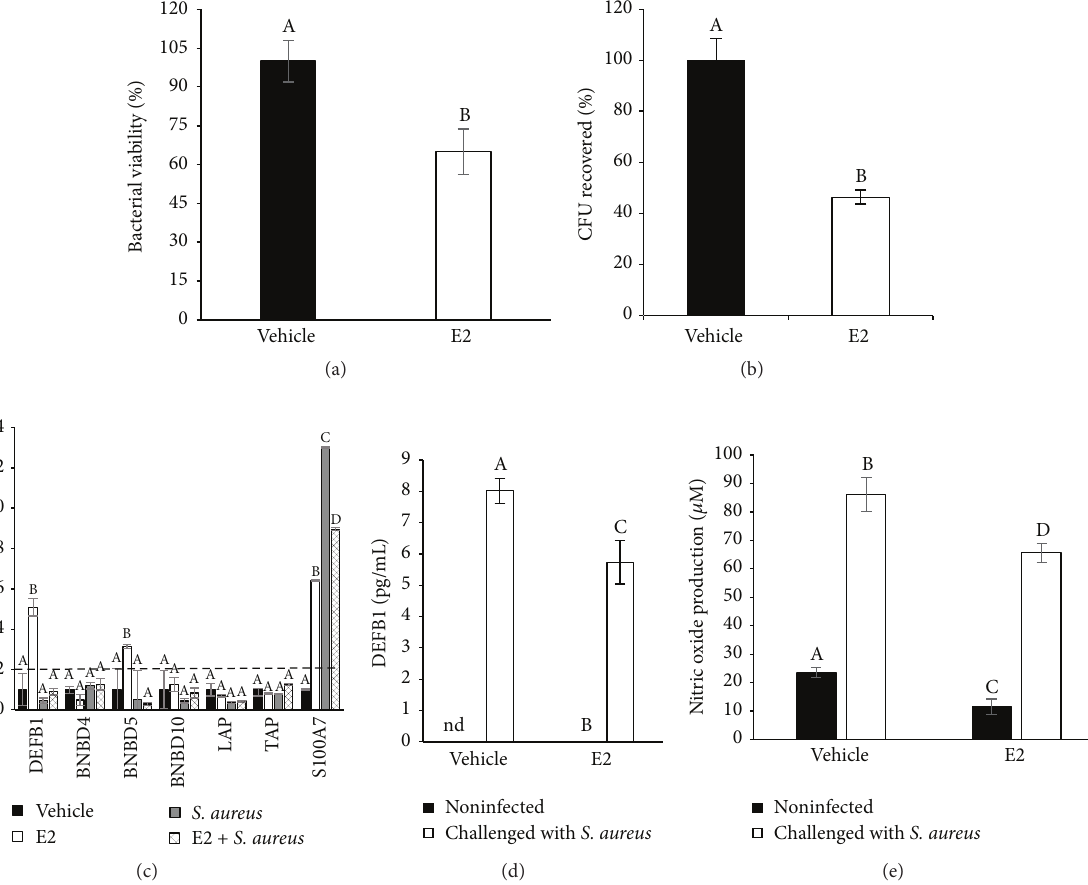
Figure 8: Expression and production of antimicrobial molecules in bMECs treated with E2 and infected with S. aureus. (a) S. aureus viability from supernatants of infection assays performed in the absence of gentamicin. Noninternalized bacteria viability was analyzed by flow cytometry using the LIVE/DEAD BacLight Bacterial viability kit. Fluorescence intensity was estimated from 10,000 events. Values were determined considering the effect of control (bMECs cultured with the vehicle 1% ethanol) as 100% of viability. (b) Effect of conditioned medium from bMECs treated with vehicle (1% ethanol) or E2 (50 pg/mL) for 24 h on S. aureus viability. Bacteria were incubated 2h with conditioned media and viability was analyzed by flow cytometry using the LIVE/DEAD BacLight Bacterial viability kit. Fluorescence intensity was estimated from 10,000 events. Values were determined considering the effect of control-conditioned medium (bMECs cultured with the vehicle1%ethanol)as100%ofviability.(c)RT-qPCRanalysisshowingthemRNAexpressionlevelsofDEFB1,BNBD4,BNBD5,BNBD10,LAP, TAP, and S100A7. The bMECs were treated with 50 pg/mL of E2 for 24 h and then challenged with S. aureus for 2h. The data are presented as the ratio of the target gene expression compared with the expression level of GAPDH. Each bar shows the mean of triplicates ± SD of three independent experiments. Fold-change values greater than 2 or less than 0.5 were considered as significant differentially expressed mRNAs. (d) Concentration of DEFB1 in culture medium of bMECs treated with 50 pg/mL of E2 for 24 h and then challenged with S. aureus for 2h. The protein concentrations were determined by ELISA. Each bar shows the mean of duplicates ± SD from different experiments, nd: nondetermined. (e) Nitric oxide production in bMECs treated with 50 pg/mL of E2 for 24h and then challenged with S. aureus for 2 h, measured as NO 2 concentration in culture medium. Each bar shows the mean of triplicates ± SE of three independent experiments. Different letters indicate significant changes among treatments ( 𝑃 < 0.05 ), except for (c), where different letters above the bars indicate significant changes among the four treatments within the same gene evaluated ( 𝑃 < 0.05 ). Vehicle: 1% ethanol.